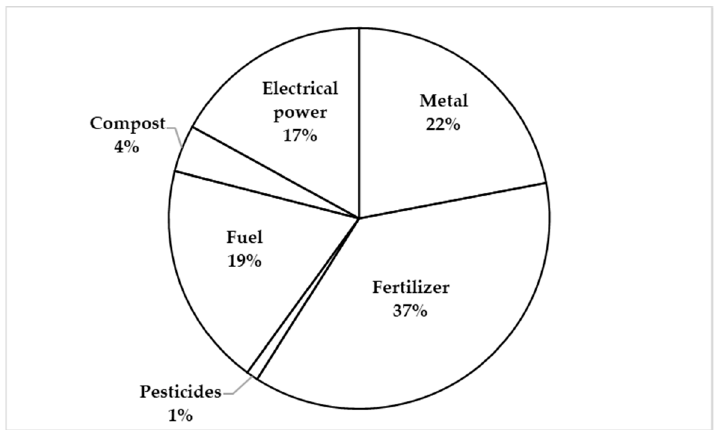
Figure 4. The relative contribution (%) of the various components in the life cycle of the vineyard to emissions.